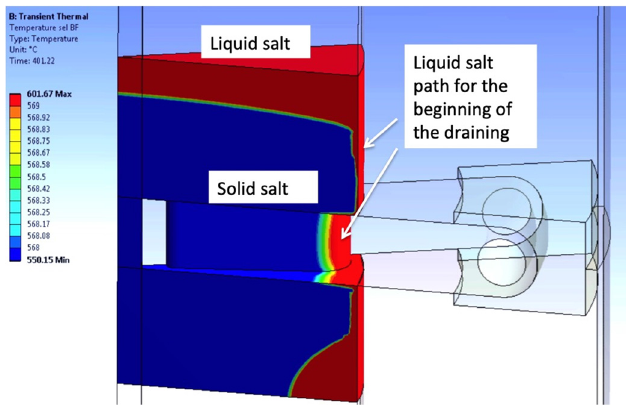
Fig. 18. Opening of the plug, the part of the plug in contact with the wall is at liquid state. The picture corresponds to a time of 400 s from the cooling and heating